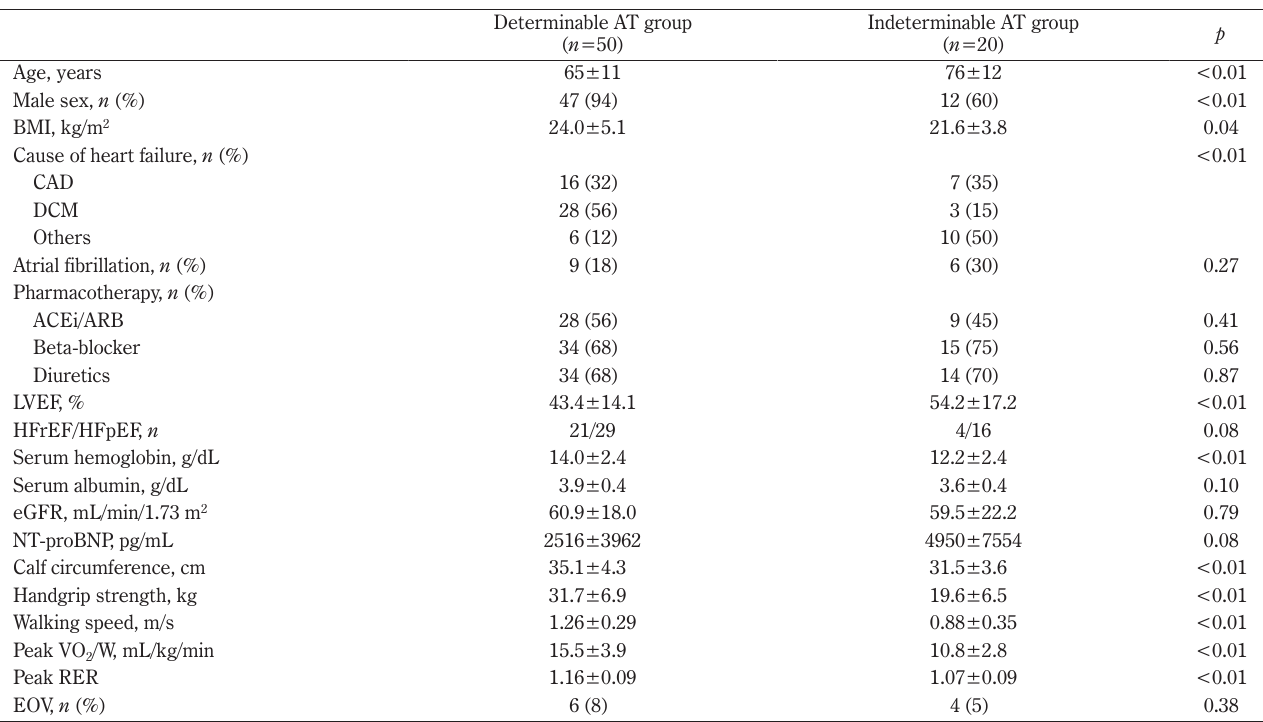
Table 1 Baseline clinical characteristics